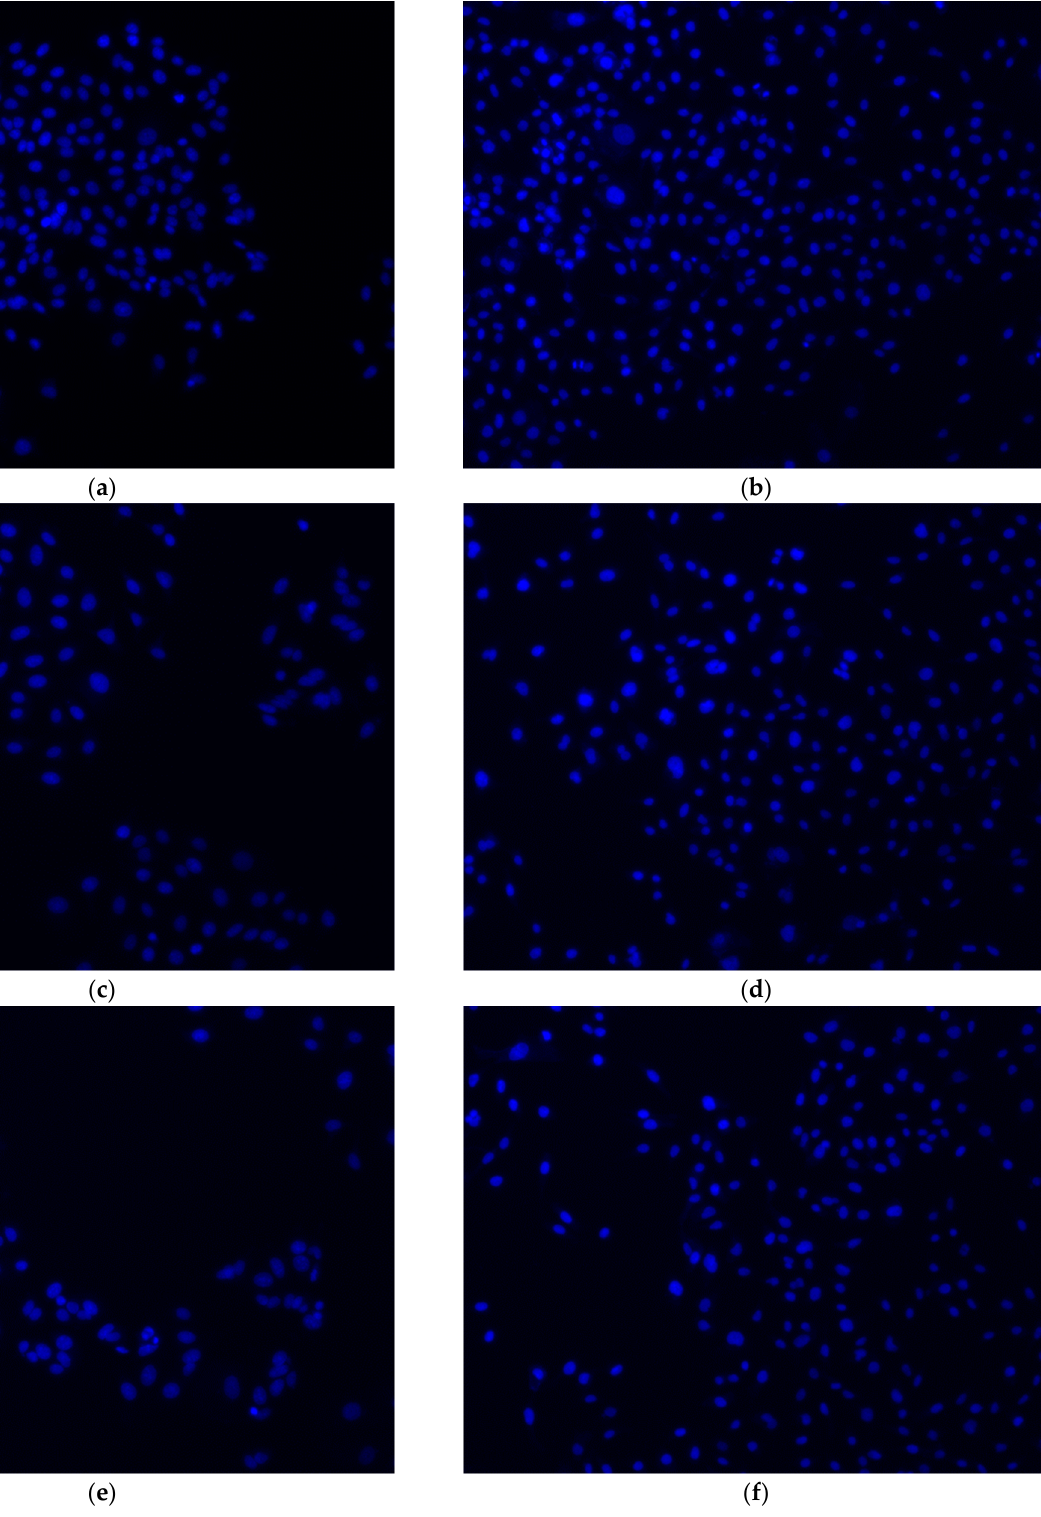
Figure 3. Representative micrographs showing nuclear morphology of MCF-7 (left column) and MDA-MB-231 (right column) cells after a 72 h treatment with ( a , b ) control ( c , d ) 2.5 mg/L, and ( e , f ) 10 mg/L o-GQD. Images are shown at 100× magnification. Images are shown at 200× magnification. The cell pointed by the white arrow is the cell where nuclear condensation and fragmentation occurs.